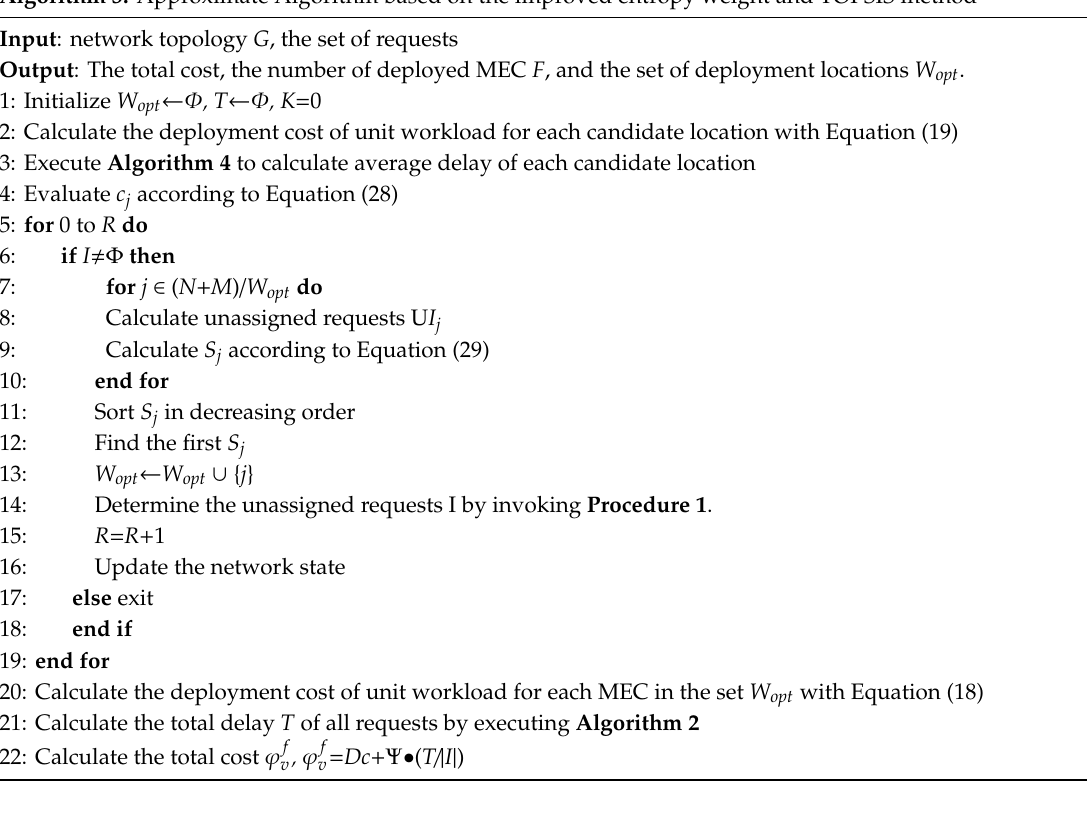
Algorithm 3: Approximate Algorithm based on the improved entropy weight and TOPSIS